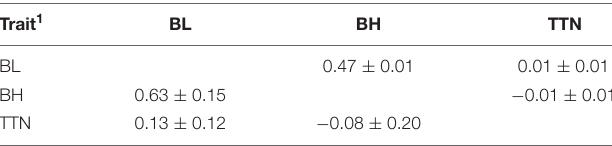
TABLE 2 | Genetic correlation and phenotypic correlation of three traits in Large White pig population. Trait 1 BL BH